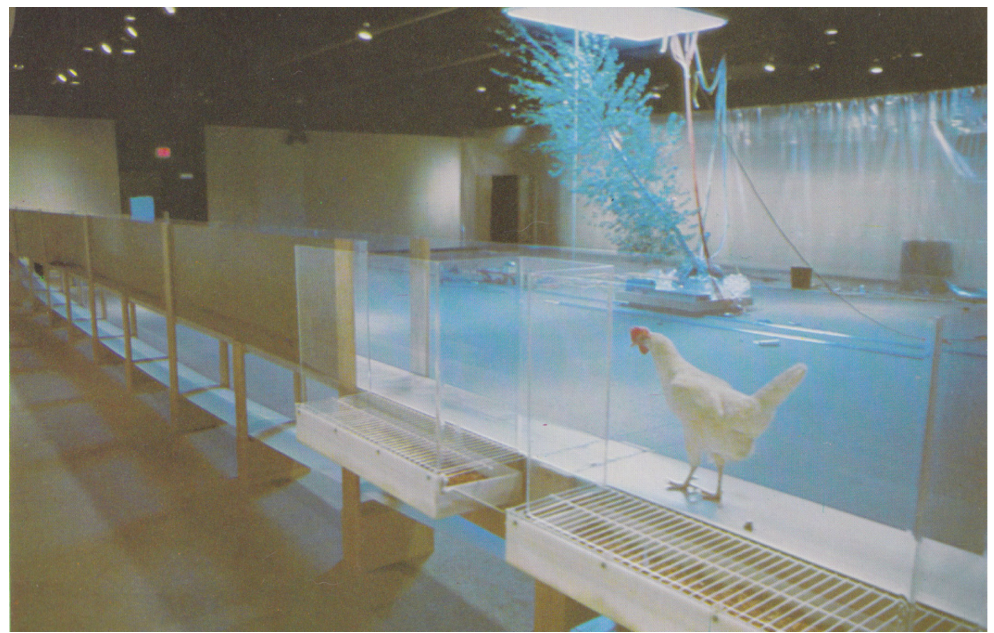
Figure 1: Noel Harding, Enclosure for Conventional Habit , six chickens, treadmill, feed and rest station, belt wash unit, motor, drive and gears, live tree, motorised cart, grow light, mist device, audio speakers, cassettes, water, power lines, rope, wire, and polythene. c (cid:13) Noel